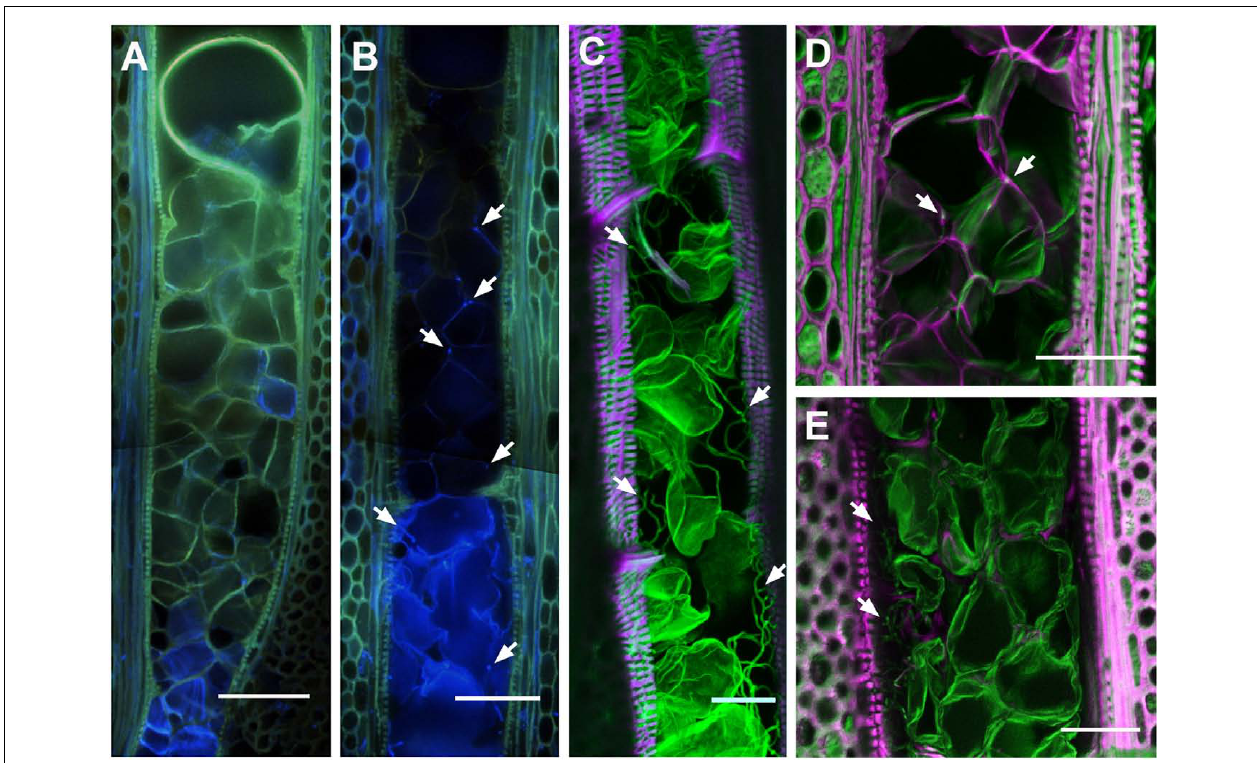
FIGURE 4 | Localization of Phaeomoniella chlamydospora hyphal structures in the xylem of infected V. vinifera L. cv Cabernet Sauvignon stem. (A,B) Epifluorescent micrograph showing tangential section of Mock (A) and P. chlamydospora inoculated (B) plants within the first mm above the point of inoculation (Auramine O, Calcofluor White M2R; UV illumination). (A) Note the positive staining of the cell wall of tyloses with Auramine O (greenish) indicating the accumulation of lignin and/or suberin. (B) Note the presence of damaged tyloses in the lower part of the vessels, not observed in the Mock inoculated plants. Also note the presence of fungal structures (bright blue spots, white arrows) associated with damage tyloses in the lower part of vessel, and along the tyloses cell wall surface in the upper part of the vessel (white arrows). Confocal micrographs of longitudinal (C–E) from the necrotic lesion of xylem tissue infected with P. chlamydospora . Samples were stained with Auramine O for the visualization of cellulo-lignified and suberized plant structures (excitation: 488 nm, emission: 505–590 nm; displayed in magenta) and calcofluor M2R white for the visualization non-lignified plant structures and fungal hyphae (excitation: 364 nm, emission: 410–505 nm; displayed in green). (C) Micrographs of a large vessel heavily colonized by fungal structures (white arrows). Note the green signal of the cell wall of tyloses indicating its incomplete maturation (i.e., absence of lignin and suberin). (D) Micrograph showing fungal structures (white arrows) at the intersection of tyloses and along the inter-tyloses cell wall boundary in a vessel fully occluded with mature tyloses (white arrows). (E) Micrograph showing a dense network of fungal structures (white arrows) in spaces between the tyloses and the wall of large vessels. (A,B) Scale bars = 100 µ m. (C–E) Scale bars = 50 µ